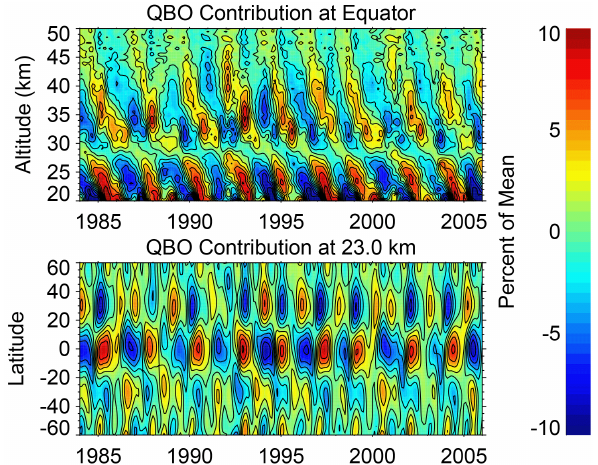
Figure 7. Examples of the QBO term. Contour lines are plotted at intervals of 2%.